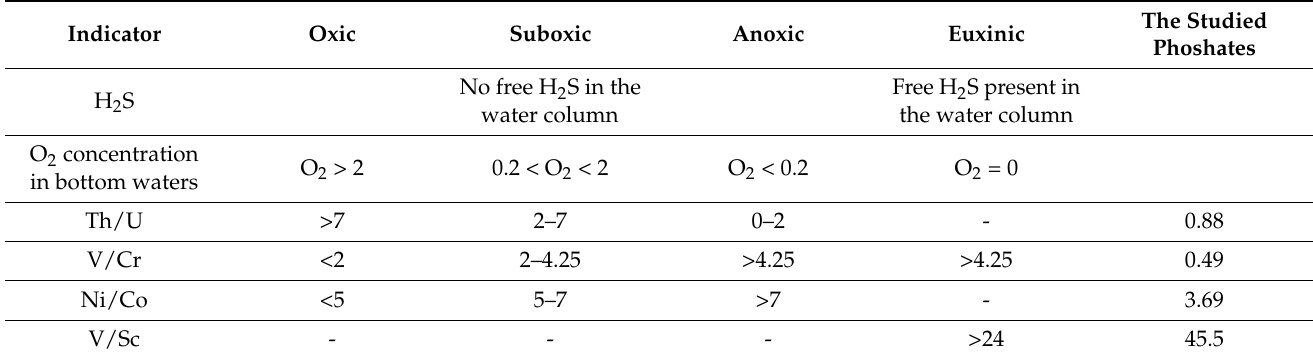
Table 4. Redox classification of the depositional environment. Data from